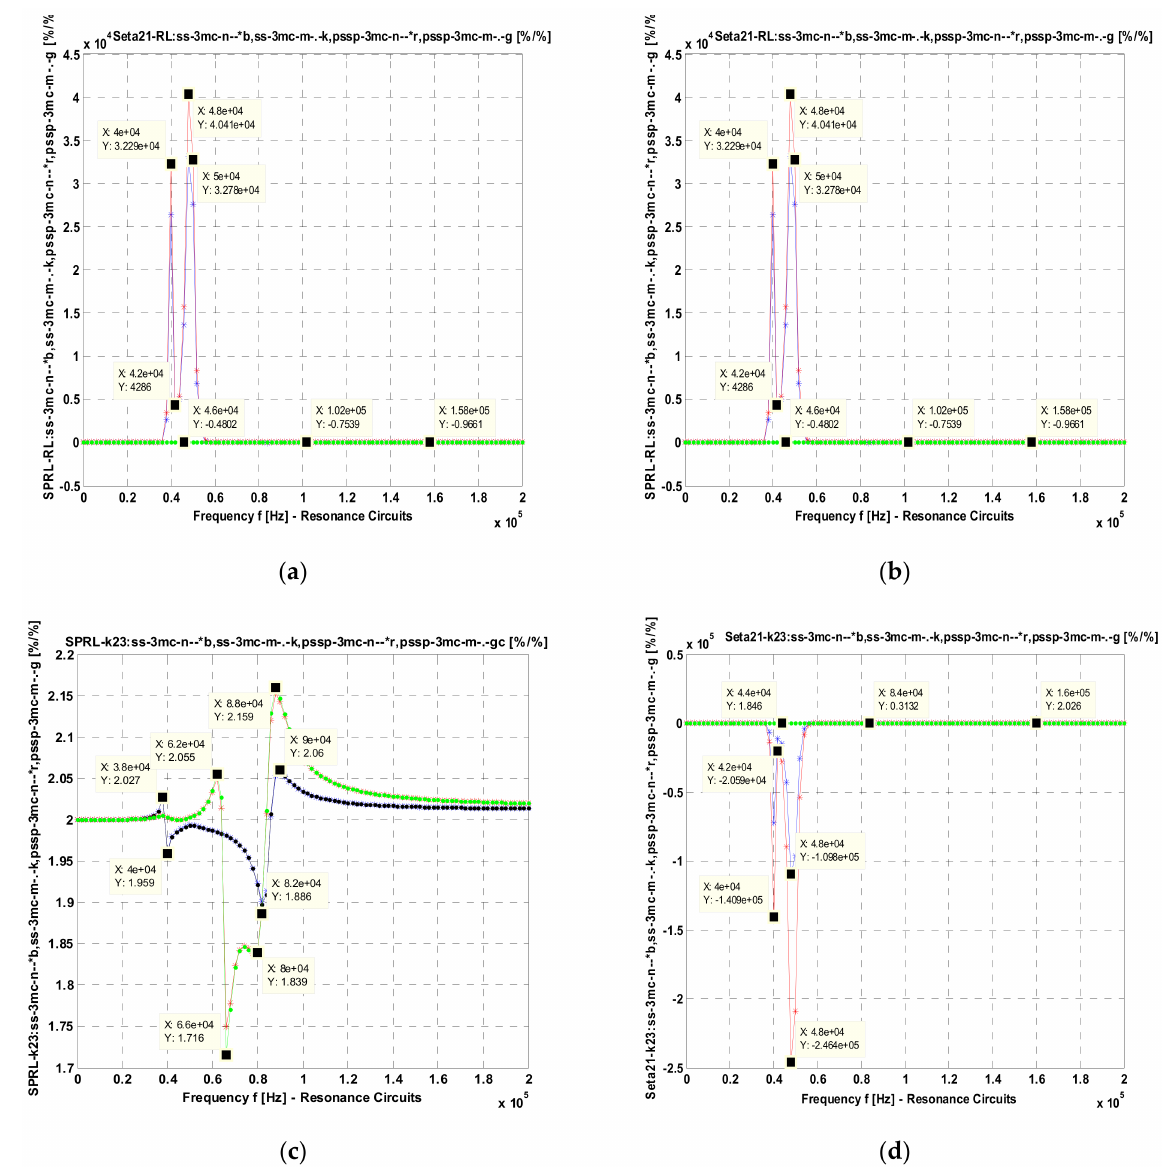
P RL for connections ss-3mc-n, ss-3mc-m, pssp- R L P RL for connection ss-3mc-n, ss-3mc-m, pssp-3mc-n and pssp-3mc-m; ( c ) S for connections R L k 23 for connections ss-3mc-n, ss-3mc-m, pssp-3mc-n and k 23